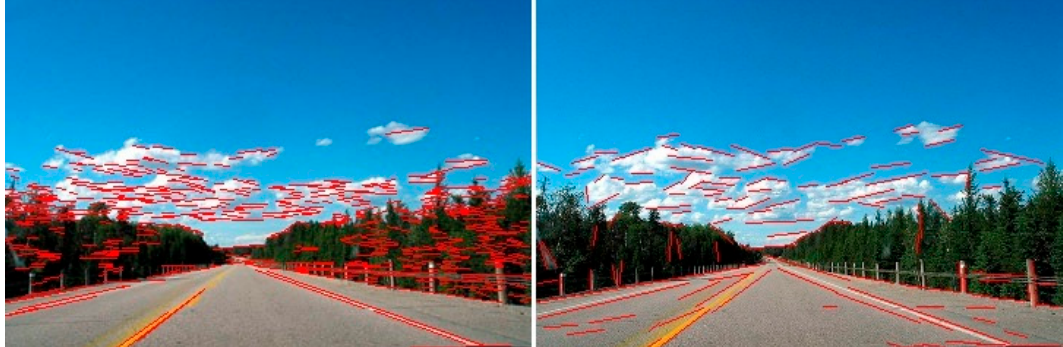
Figure 2. Comparison of line segment detection results. The left column is the Hough method. The right column is the line segment detector (LSD) method.